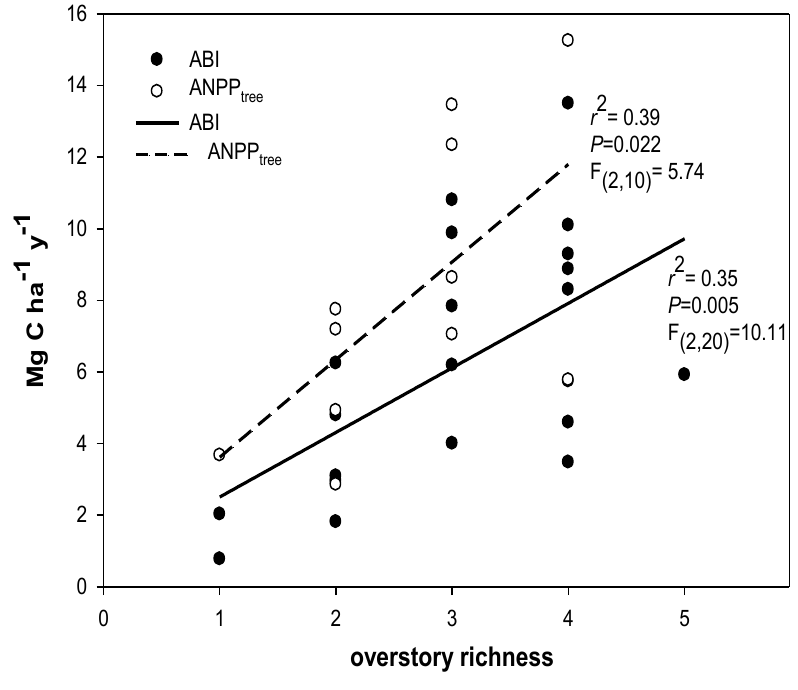
Figure 2. Positive relationships between Aboveground Biomass Increment carbon (ABI) , Aboveground Net Primary Productivity of trees (ANPP which includes the five most dominant tree species; P . menziesii, A. macrophyllum , A. rubra , T. heterophylla, and T.